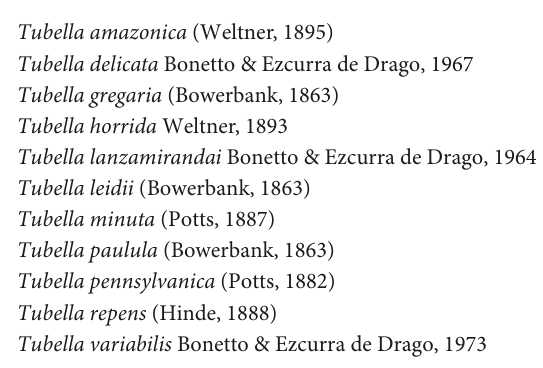
FIGURE7 (A–I) Racekiela Bass & Volkmer-Ribeiro, 1998. Gemmuloscleres. (A–G) Birotules, short thin, or robust shafts with smooth or with few spines; (H,I) pseudobirotules with long and spiny shaft. Scale: 10 µ m.